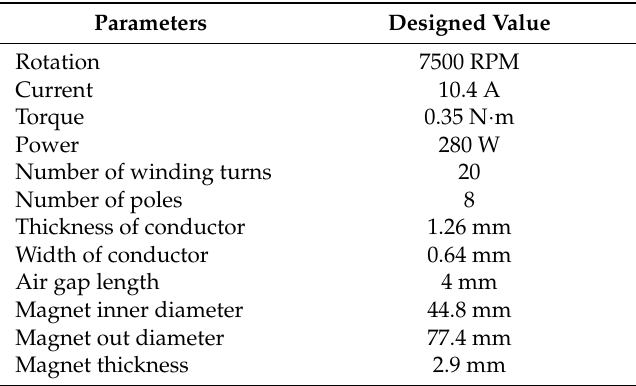
Table 2. Basic parameters of the prototype with improved